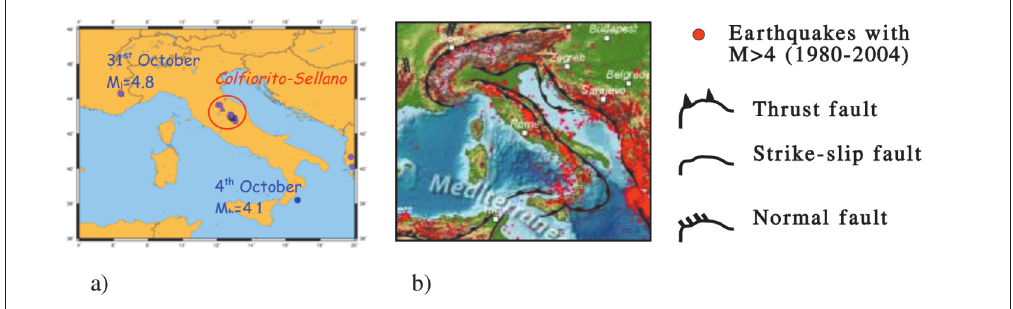
Fig. 4. a) October 1997 event map (source IRIS, http://www.iris.washington.edu); b) tectonic and seismicity map of the Mediterranean West (source National Earthquake Information Centre –